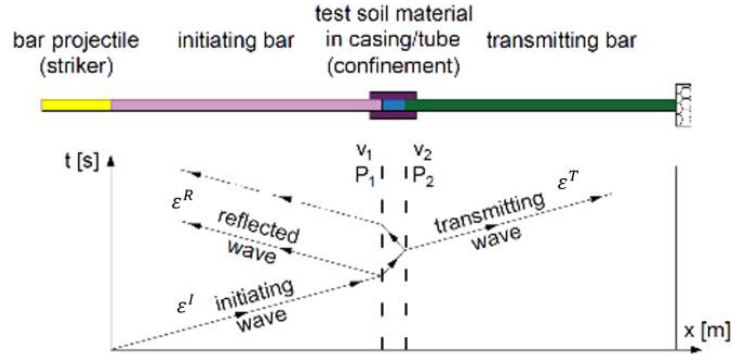
Figure 3. Wave diagram showing the phenomenon of propagation of elastic waves in SHPB (reprinted from Ref. [70]).